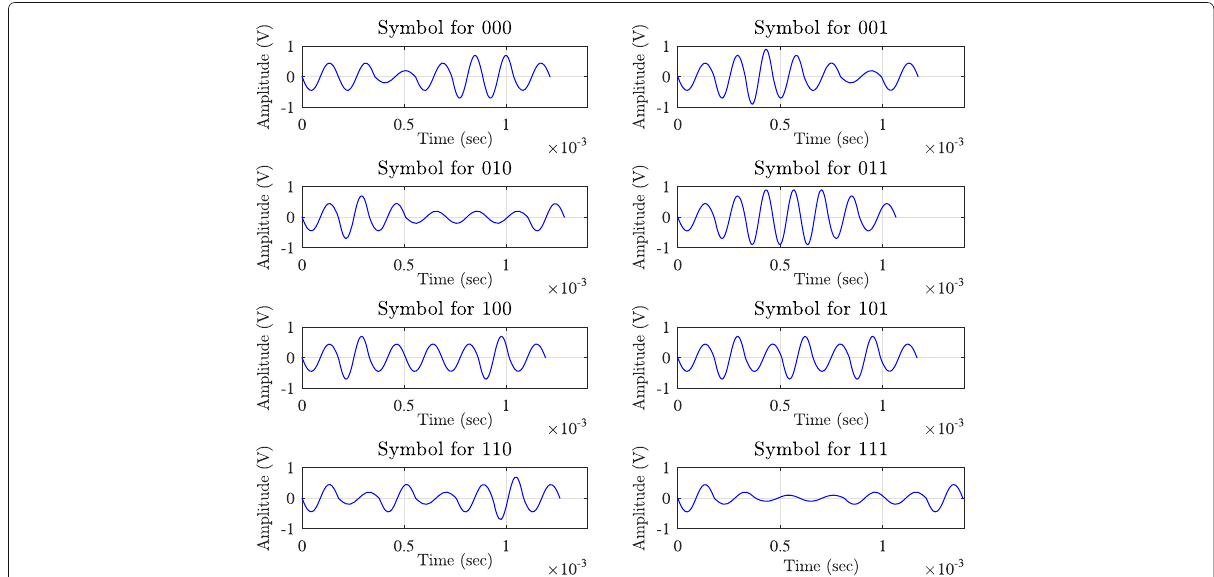
Fig. 2 The 3-bit glossary space with 5 levels, each of which has 7 patterns (depth is set to 6). The signal’s amplitude is [0.1,0.2,0.45,0.7,0.9] V, frequency is [4.600,5.000,5.600,6.600,7.400] kHz, and phase shift is [ − π /2 − π /4 0 π /4 π /2]